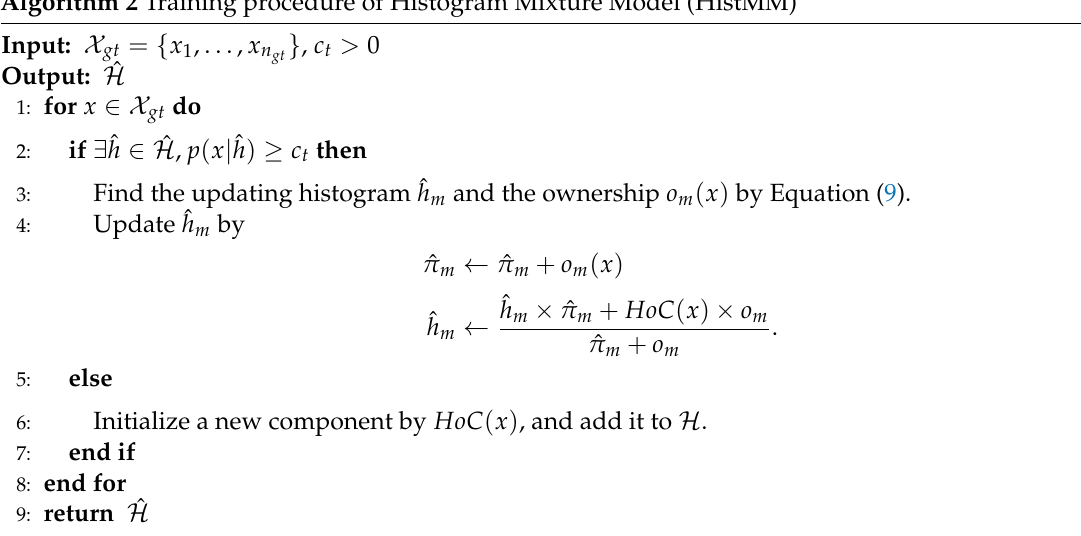
Algorithm 2 Training procedure of Histogram Mixture Model (HistMM)